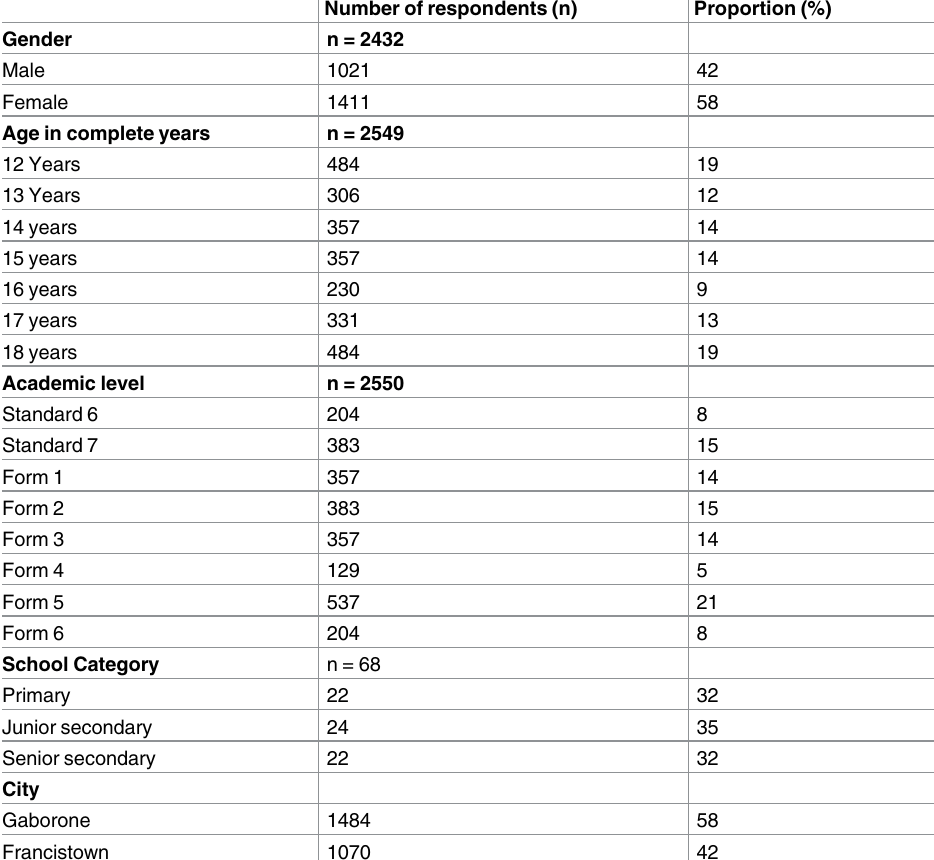
Table 1. Characteristics of study